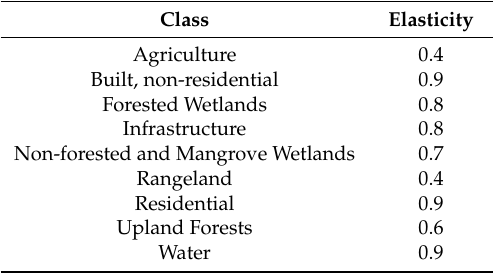
Table 3. Elasticity values for land conversions of each LULC